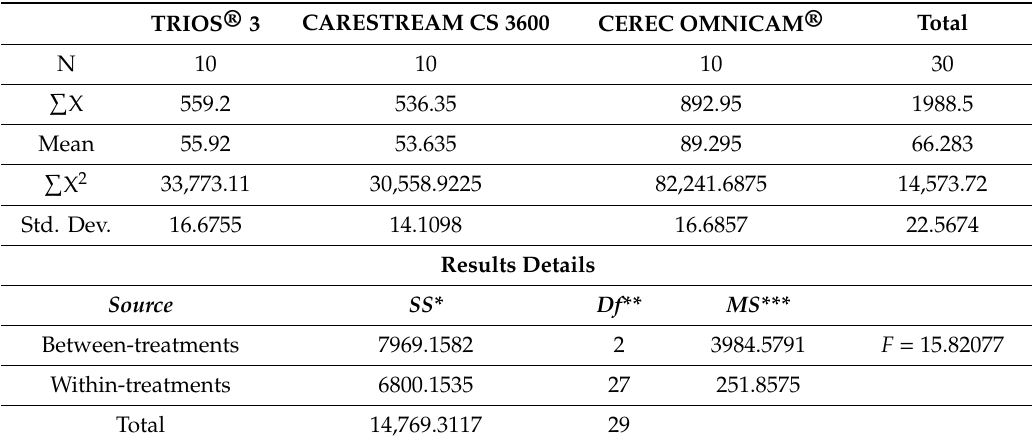
Table 9. Distance between reference lines and test ones in sample 4 without saliva.